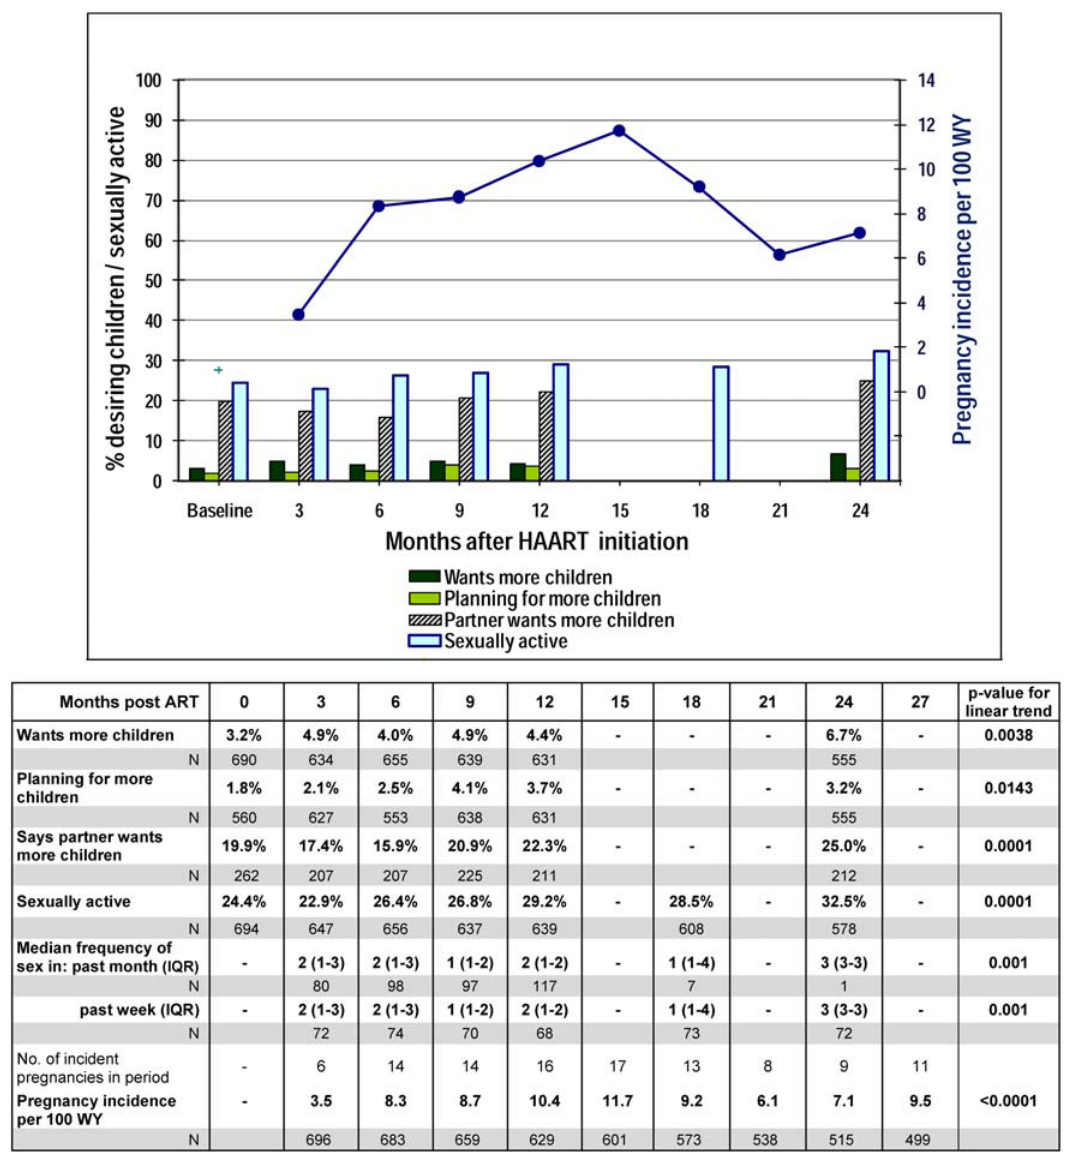
Figure 2. Desire for children and incidence of pregnancy among HBAC women on ART.